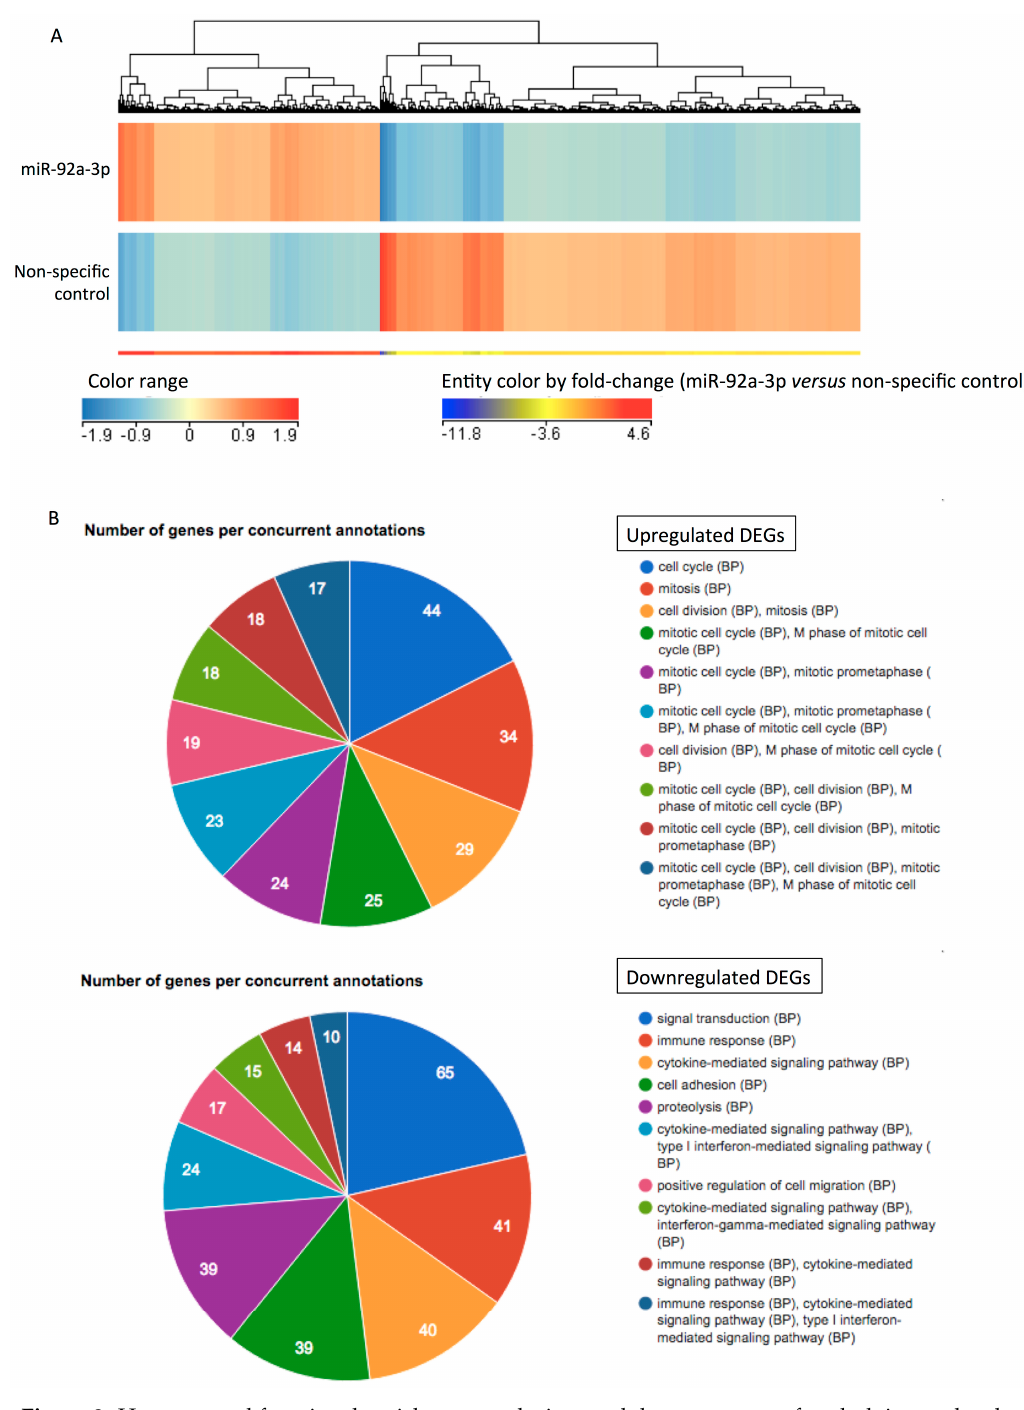
Figure 3. Heatmap and functional enrichment analysis reveal the occurrence of underlying molecular events in HUVECs transfected with miR-92a-3p. ( A ) Heatmap and hierarchical clustering analysis of differentially expressed genes (DEGs; p -value < 0.05 and fold-change ≥ 2) in HUVECs transfected with miR-92a-3p compared with those in HUVECs transfected with nonspecific control miRNA. Each column represents the relative expression level of individual genes. The red or blue color indicates relatively high or low expressions, respectively. Entity colors by fold-change (miR-92a-3p/nonspecific control) are also described below the heatmap. ( B ) Functional enrichment analysis of up- and downregulated DEGs, including the top 10 gene ontology terms. BP, biological process; miRNA, microRNA; EV, extracellular vesicle; HUVEC, human umbilical vein endothelial cell; DEG, differentially expressed gene.